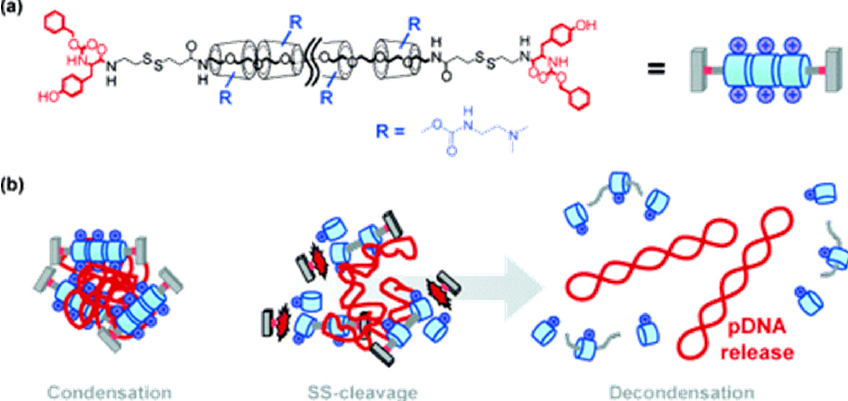
Figure 12. Chemical structure of biocleavable polyrotaxane: ( a ) polyplex formation and ( b ) terminal cleavage-triggered de-condensation of the polyplex. Reprinted with permission from Reference [210]. Copyright 2006 American Chemical Association.